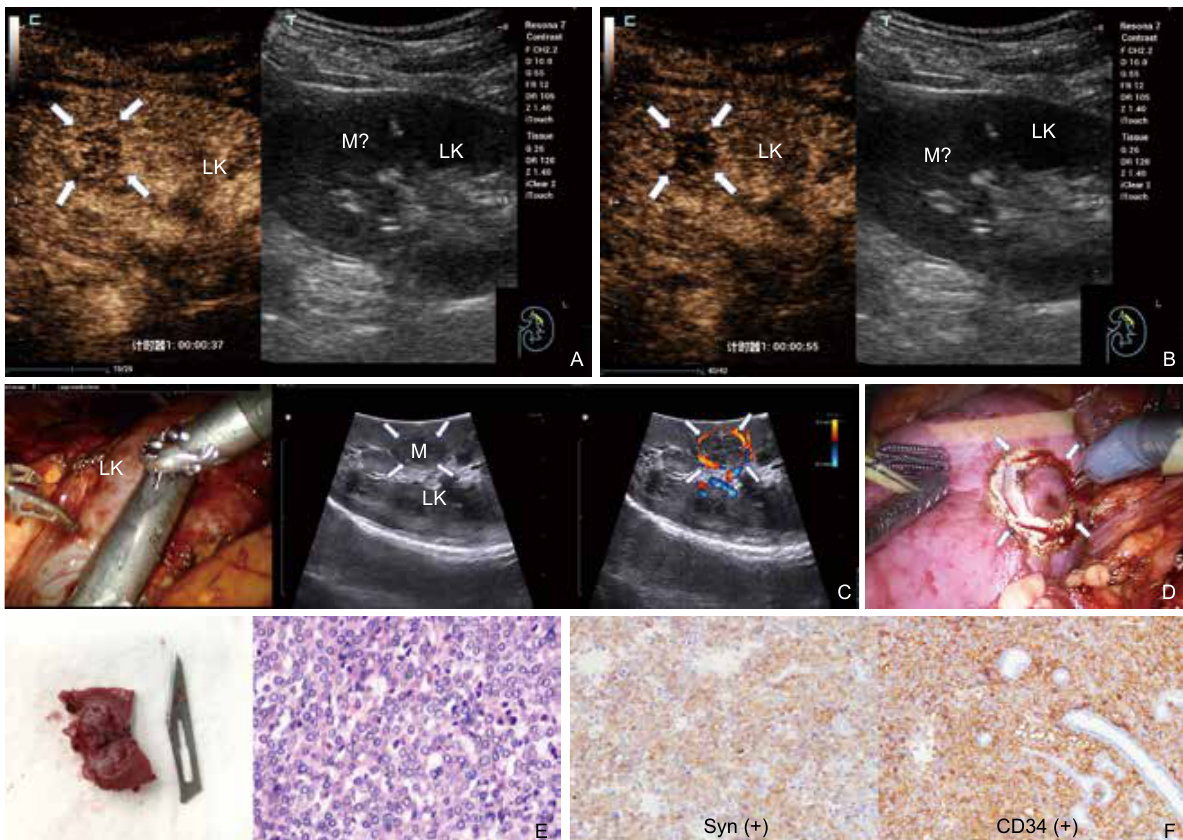
Figure 2 A 15-year-old woman was diagnosed with reninoma on pathological examination. (A) Conventional ultrasound showed left upper renal tumor. CEUS showed a low enhancement focus. (B) CEUS showed continuous low enhancement. (C) Ultrasound showed low echo, clear boundary, regular shape, and low echo halo around the mass, color Doppler showed blood flow signal around and inside the mass. (D) After tumor location and boundary were determined by intraoperative ultrasound, an electric hook was used to mark along the edge of the tumor. (E) Gross tumor specimens were resected along the mark, and sent to pathology, and the pathological findings suggested reninoma (hematoxylin and eosin, 200 ' ). (F) Diagnosis of reninoma was confirmed by immunohistochemistry, Syn (+), CD34 (+) (hematoxylin and eosin,